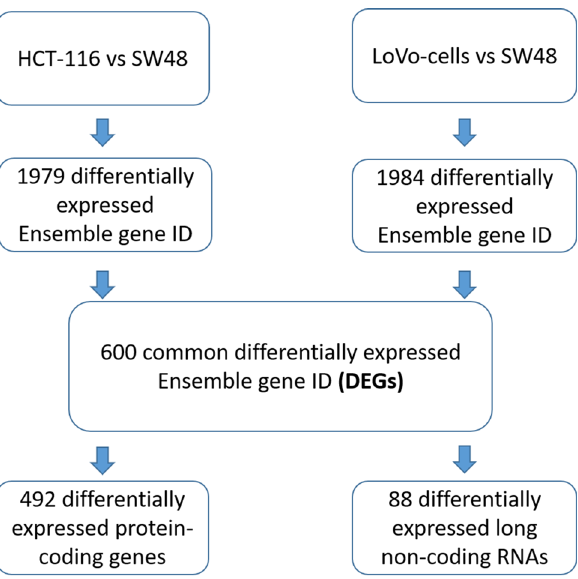
Figure 1. Design of the study. Schematic diagram for a multi-step strategy to identify DEGs and DEncRNAs associated with the KRAS